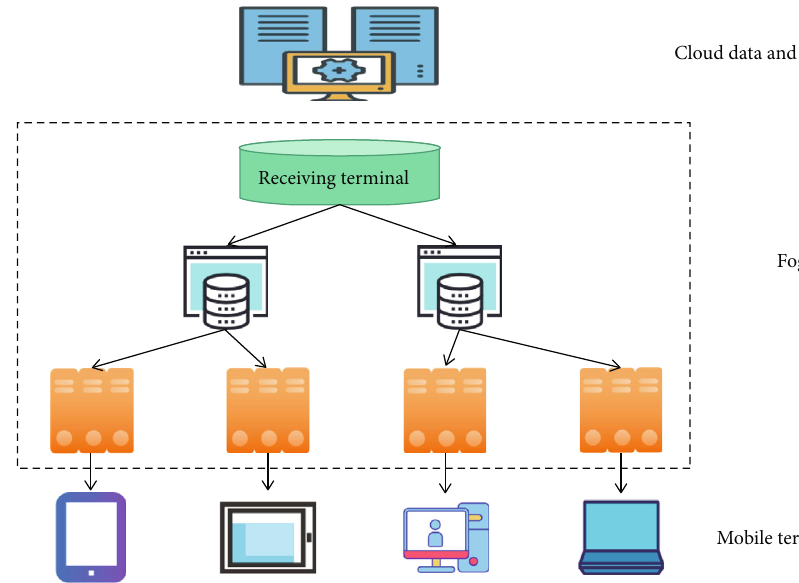
Figure 2: Schematic diagram of the fog computing